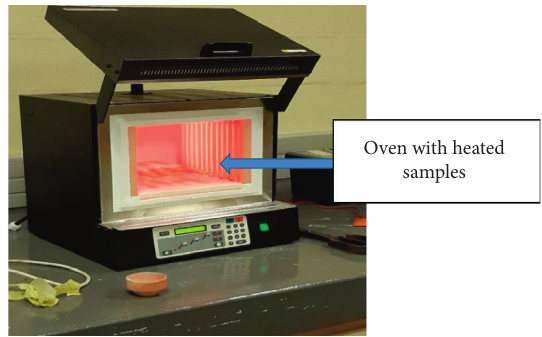
Figure 3: Furnace during heat treatment of samples.